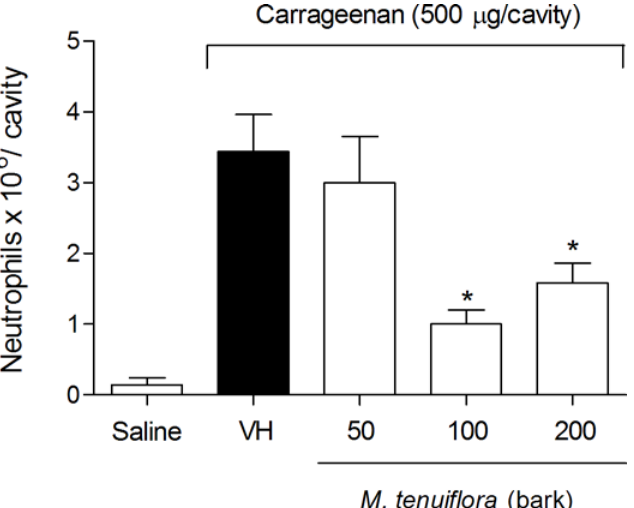
Fig 5. Effect of ethanolic extract of M . tenuiflora bark on neutrophil migration into the peritoneal cavity of mice pretreated subcutaneously 30 min prior to Cg injection (500 μ g/cavity) to induce peritonitis. VH is the vehicle group (negative control). The ethanol extract of M . tenuiflora bark was tested at doses of 50, 100 or 200 mg/kg (s.c.). The results are presented as the mean ± S.D. (n = 8). Statistical significance was calculated by ANOVA followed by Bonferroni's test. * P < 0.05 compared to the vehicle- negative control treated